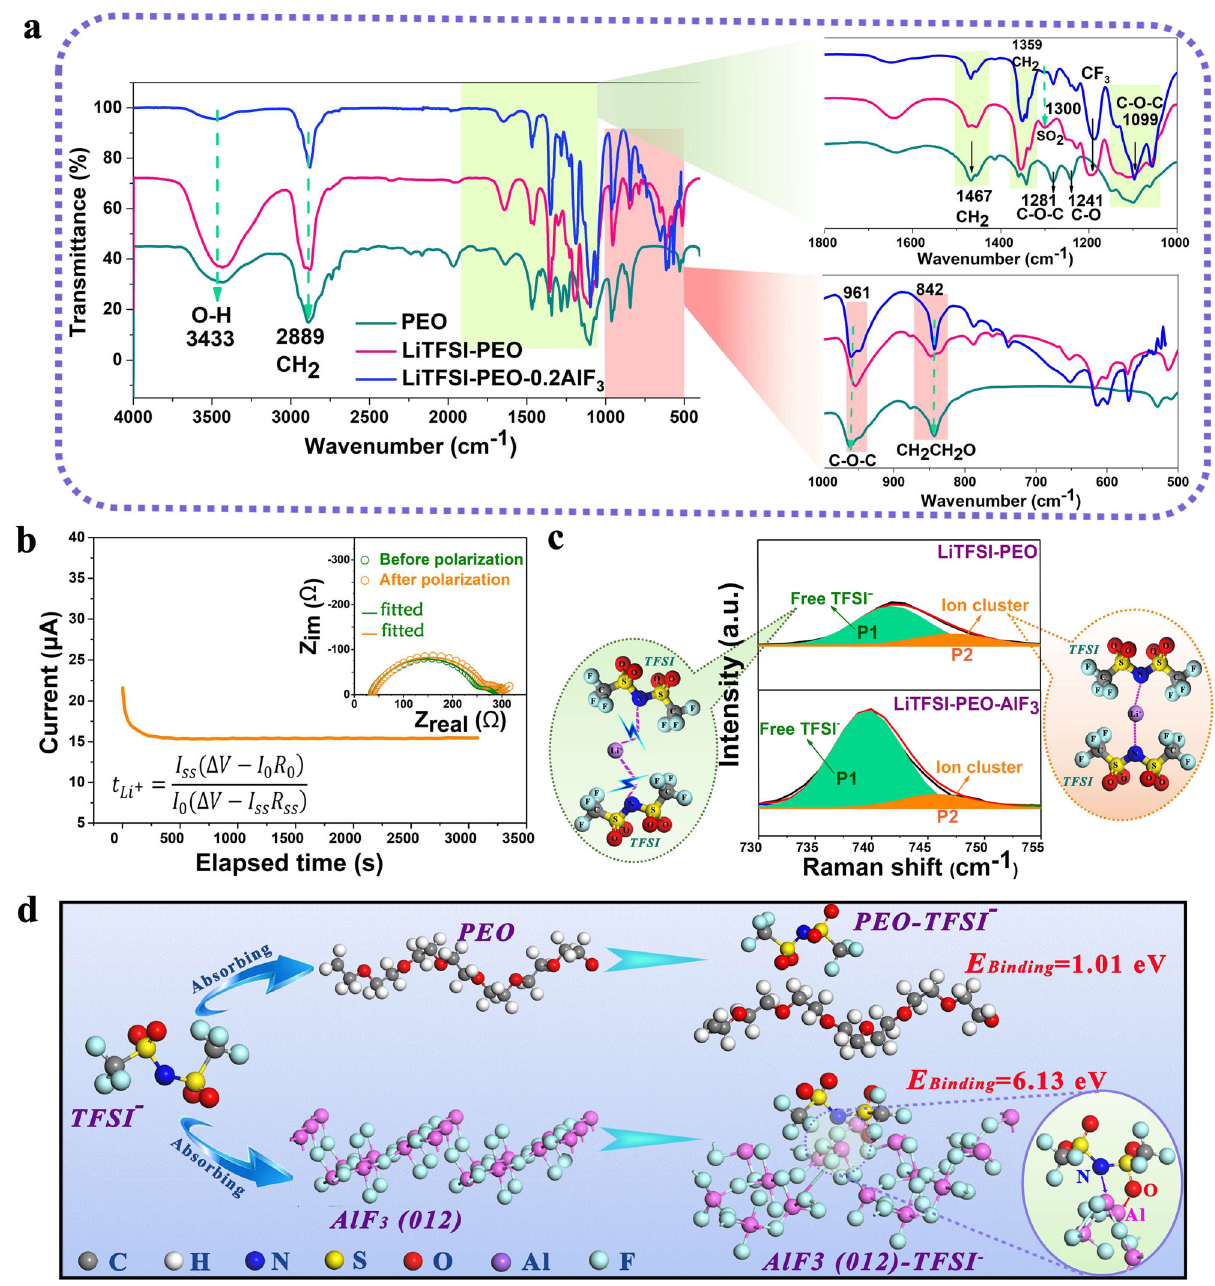
Fig.4|SurfaceinteractiondetectionbetweenHS-AlF 3 andPEOorLiTFSI.a FTIR spectra of PEO, LiTFSI-PEO and LiTFSI-PEO-0.2AlF 3 . The ampli fi ed spectra in the wavenumberrangesof1000 – 1800cm − 1 and500 – 1000cm − 1 areshownasinsetson theright. b ChronoamperometrycurveofLi|LiTFSI-PEO-0.2AlF 3 |Lisymmetriccellat avoltagebiasof10mVforadurationtimeof3100s,inset:ACimpedancespectraof